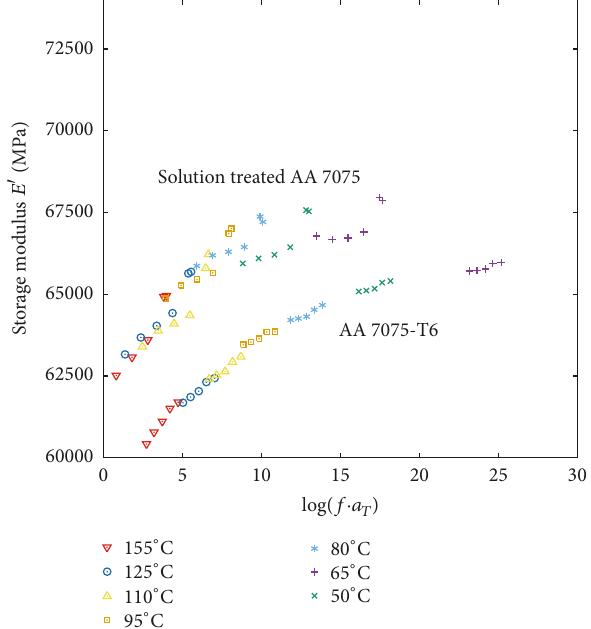
Figure 5: Master curve showing the storage modulus 𝐸 󸀠 versus the logarithm of the frequency 𝑓 times the shift factor 𝑎 𝑇 . These curves resulted from horizontal shifting of the isothermal 𝐸 󸀠 curves from DMA tests on AA 7075-T6 and solution treated AA 7075, at temperatures from 50 to 155 ∘ C.